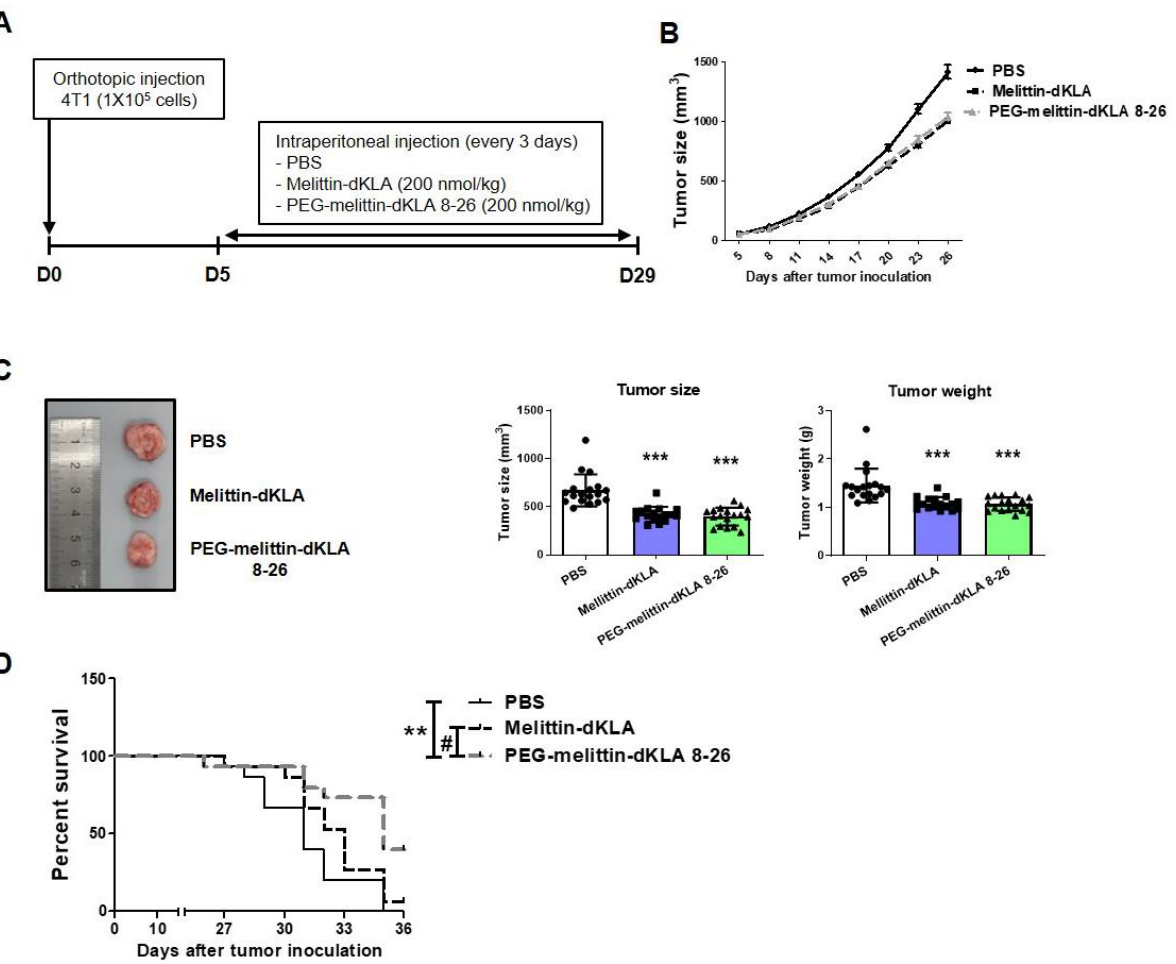
Figure 5. Inhibition of tumor growth and increased survival rates by PEG-melittin-dKLA 8-26 in the 4T1 TNBC mouse model. ( A ) In vivo experiment schedule. ( B ) The volume of the tumor was meas- ured using a digital caliper. Tumor volume was calculated using the following equation: (width × width × length)/2. ( C ) To access tumor volume and weight, mice were euthanized on day 29 after tumor inoculation. Tumor tissues were imaged, and tumor volume and weight were measured us- ing a digital caliper and electronic scale, respectively, after sacrifice. All data are presented as the mean ± SEM; *** p < 0.001 versus the PBS group (n = 18). ( D ) Mouse survival was calculated as the life span from the day of tumor inoculation. The median survival and p values were determined using the Log-rank test. ** p < 0.01 versus the PBS group, # p < 0.05 versus the melittin-dKLA group (n = 15).